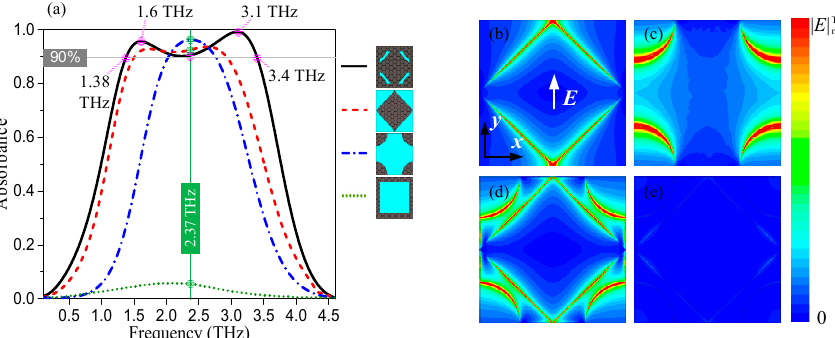
Figure 3. ( a ) The absorption spectra for the absorbers based on the patterned graphene unit cell with only square (red dash), four quarter-disk (blue dash-dot), square-loop (green dot), and the proposed hybrid square/disk/loop (black solid) resonators, under the same dimension parameters shown in Figure 1; ( b ), ( c ), and ( d ) are the normalized | E | distributions for TE polarization of the absorbers with only square, disk, and hybrid patterned graphene, respectively, on the graphene plane with high absorption at 2.37 THz; ( e ) is the normalized | E | distributions for TE polarization of the proposed absorber on the graphene plane with low absorption at 4.5 THz.